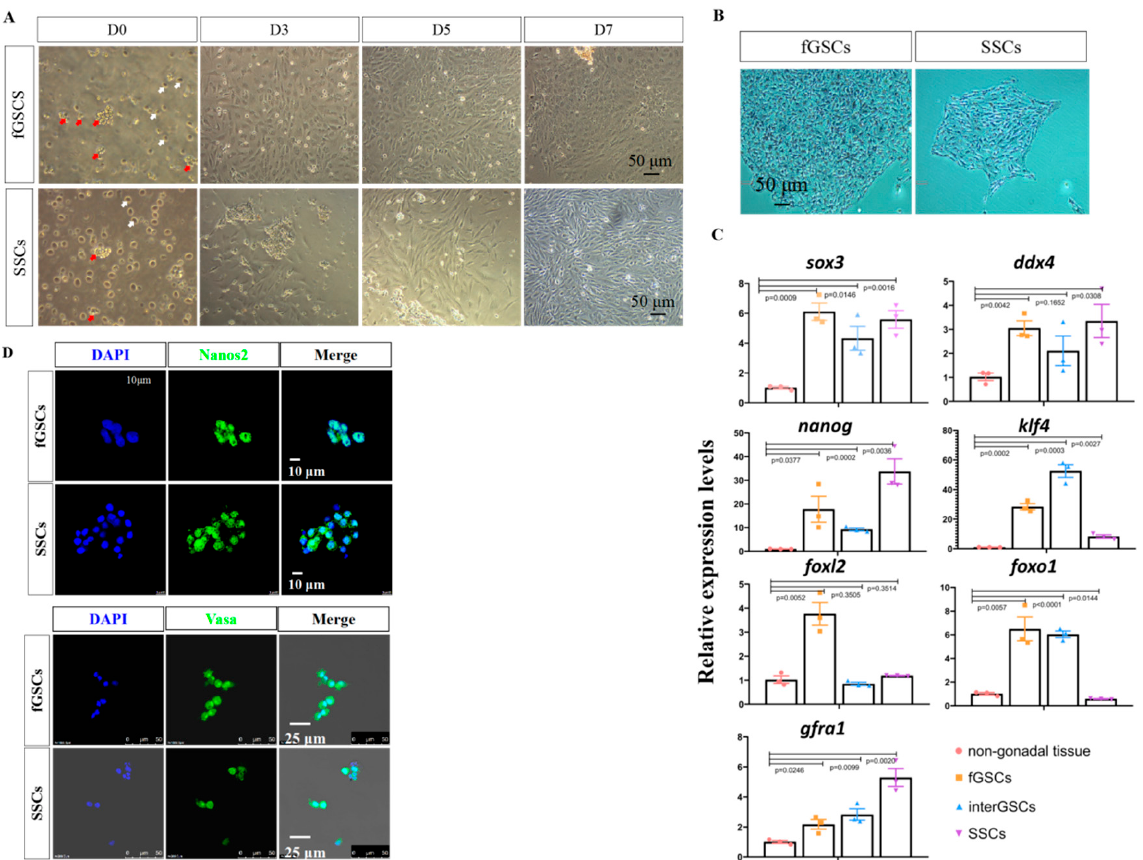
Figure 2. Isolation and characterization of GSCs derived from ovary and testis. ( A ) Cell morphology of GSCs isolated from ovary and testis at the indicated time points. Red arrows show the grape-like GSCs, and the white arrows show the blood cells. ( B ) AP staining images of fGSCs and SSCs. ( C ) qRT-PCR results of pluripotency- and GSC-specific genes in the isolated fGSCs, interGSCs, and SSCs. The spleen was used as the non-gonadal control. ( D ) Immunofluorescence staining results of Nanos2 and Vasa in fGSCs and SSCs.